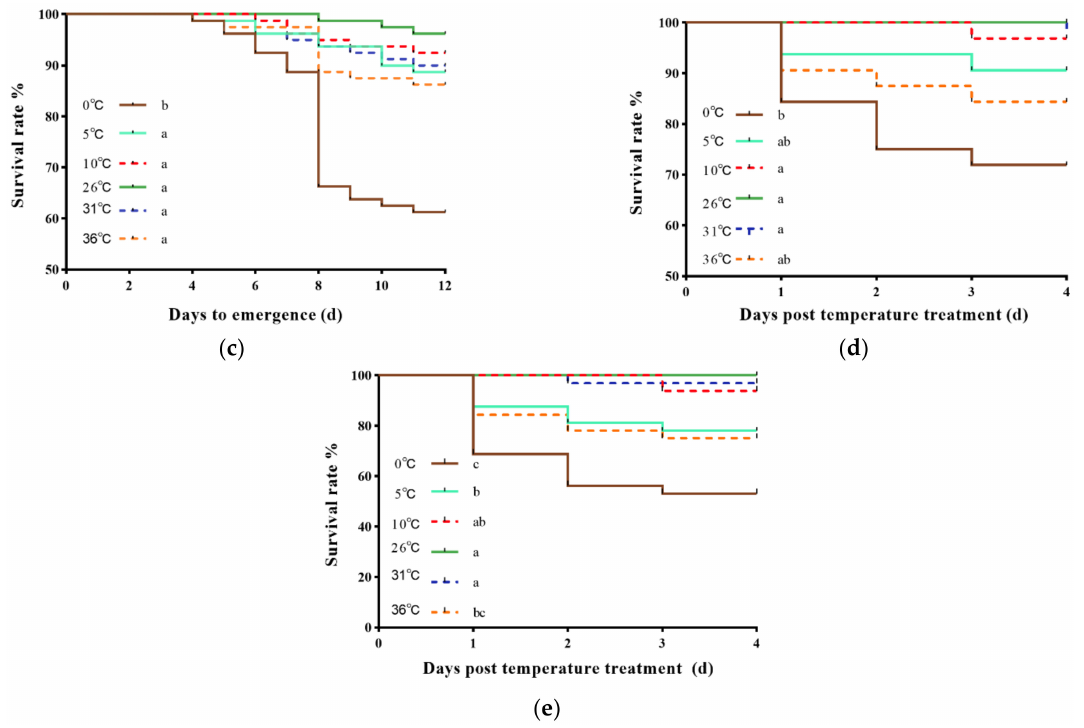
Figure 1. Survival rates of eggs ( a ), larvae ( b ), pupae ( c ), female adults ( d ), and male adults ( e ) of B. dorsalis subjected to various short-term high- and low-temperature treatments. The number of individuals analyzed in different stages: eggs = 80, larvae = 80, pupae = 80, female adults = 32, and male adults = 32. Different lowercase letters on the right side of the different groups indicate significant differences among different treatments. Survival rates were estimated using the Kaplan– Meier method ( p < 0.05, log-rank (Mantel–Cox) test).